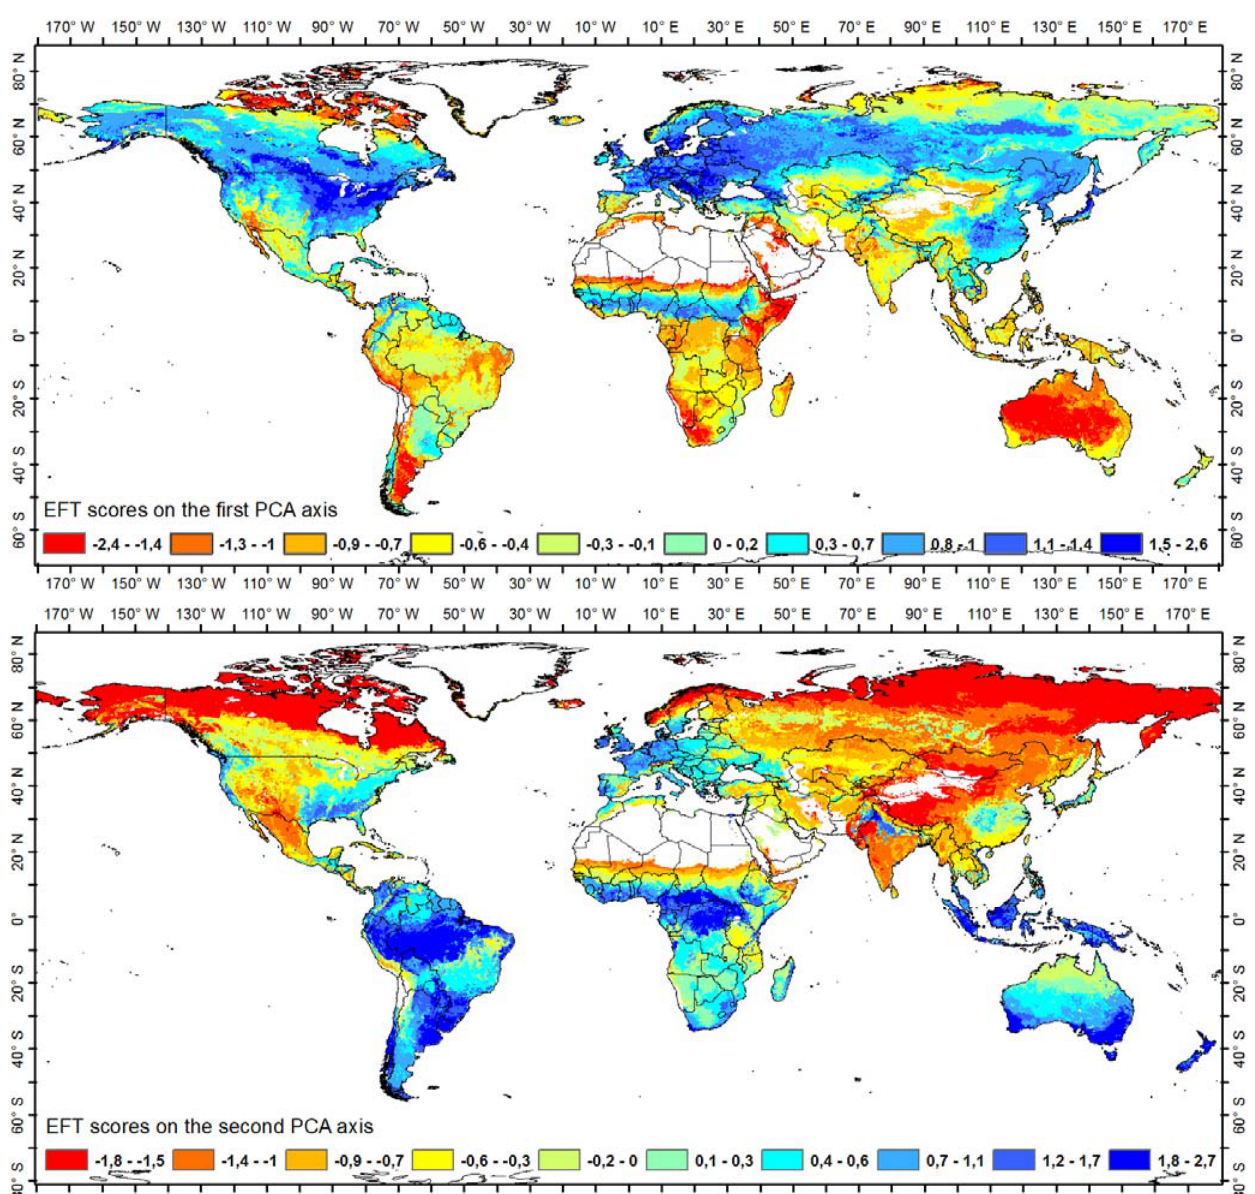
Figure 4. Spatial patterns of the first ( top ) and second ( bottom ) axis of the gradient PCA ordination of the selected Phenolo variables averaged within the EFT clusters. White areas represent pixels without vegetation